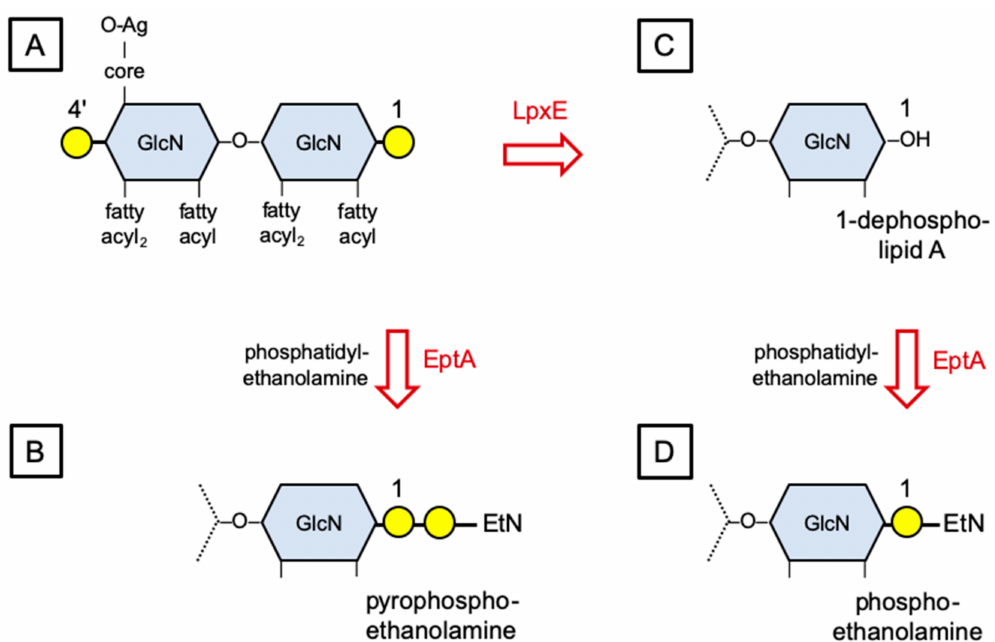
Figure 3. EptA (phosphoethanolamine transferase) and LpxE (lipid A 1-phosphatase) activities. ( A ) Lipid A schematic structure. The glucosamine disaccharide is decorated with six fatty acyl chains, the core oligosaccharide that ligates the polymorphic O-antigen (O-Ag) polysaccharide, and phosphate esters at positions 1 and 4’. ( B ) EptA enzyme adds phosphoethanolamine (P-EtN) to form a pyrophosphoethanolamine moiety. Only one glucosamine from the lipid A disaccharide is shown, but the same reaction also can occur at the 4’ position. ( C ) LpxE enzyme removes phosphate-1. ( D ) EptA enzyme adds P-EtN to form a phosphoethanolamine moiety. See text for